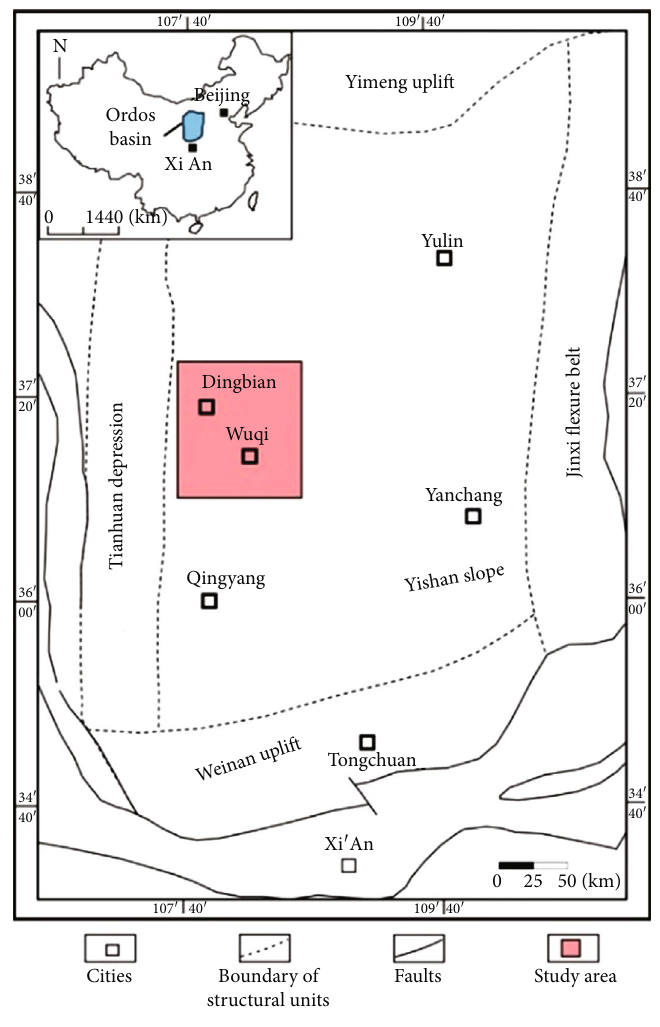
Figure 1: Structural location of study area in the Ordos